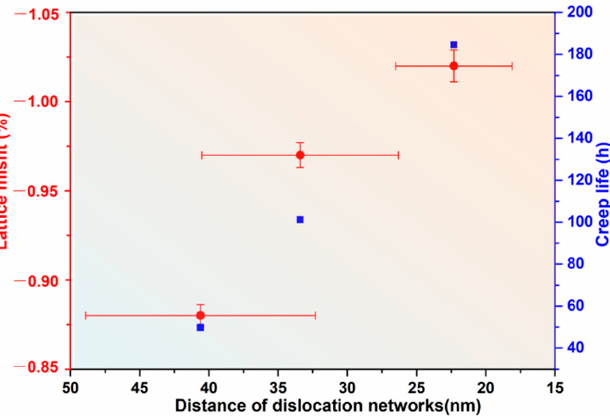
Figure 14. The lattice misfit and dislocation network spacing after 10 h of creep interruption at 1100 °C/137 MPa, and denser dislocation networks showed longer creep life. Table 6. γ - and γ (cid:48) phase compositions after interruption of crept 10 h